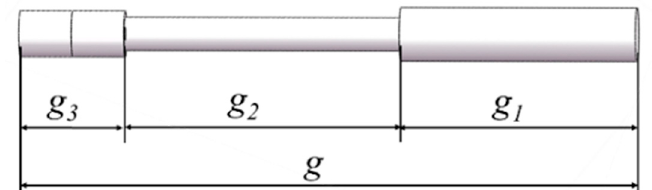
Figure 15. Component of steel bar.